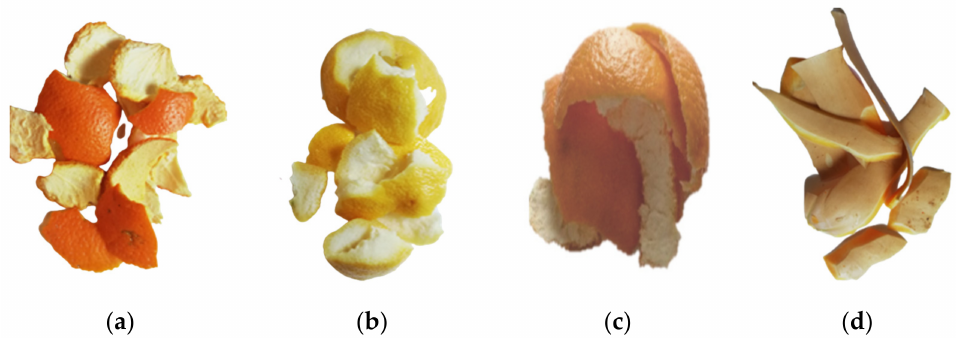
Figure 1. Biomass waste used in the experiment: ( a ) mandarin peel, ( b ) lemon peel, ( c ) grapefruit peel, and ( d ) butternut-squash